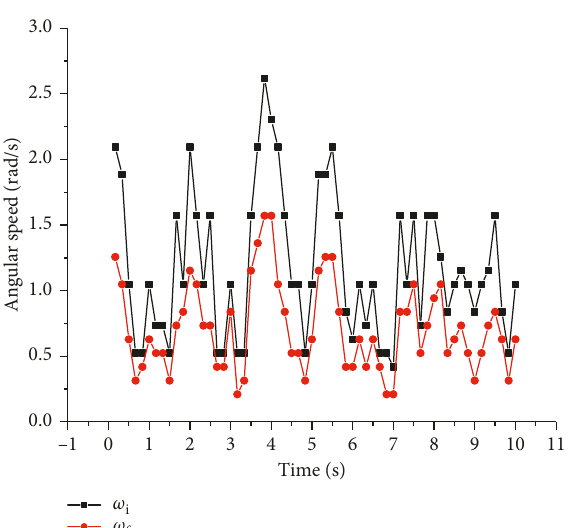
Figure 14: Specific angular speed value between the sleeve (with 12 rollers) and the shaft ( ω f / ω i